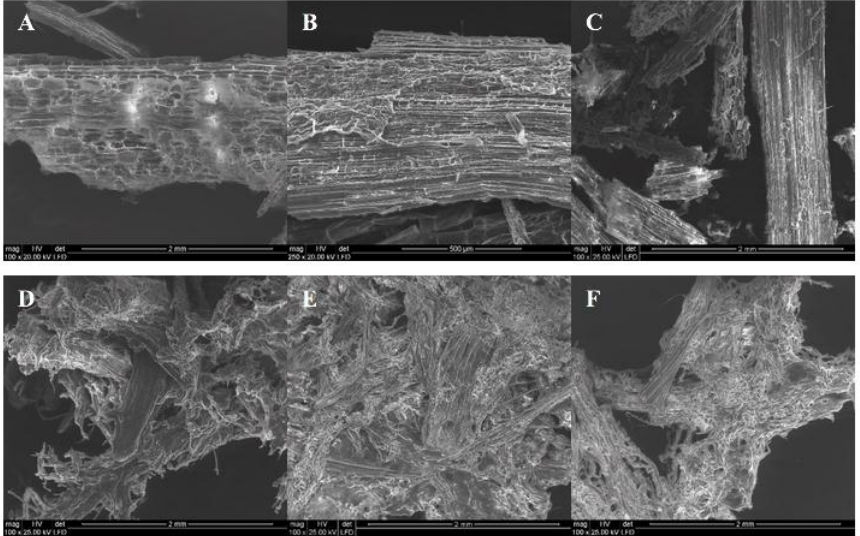
Figure 1. Scanning electron microscopic images of buckwheat straw: ( a ) without pretreatment; ( b ) after processing with EMIMCl; ( c ) after processing with EMIMDEP; ( d ) after processing with EMIMOAc; ( e ) after processing with BMIMOAc; and ( f ) after processing with EMIMOAc and EMIMCl.